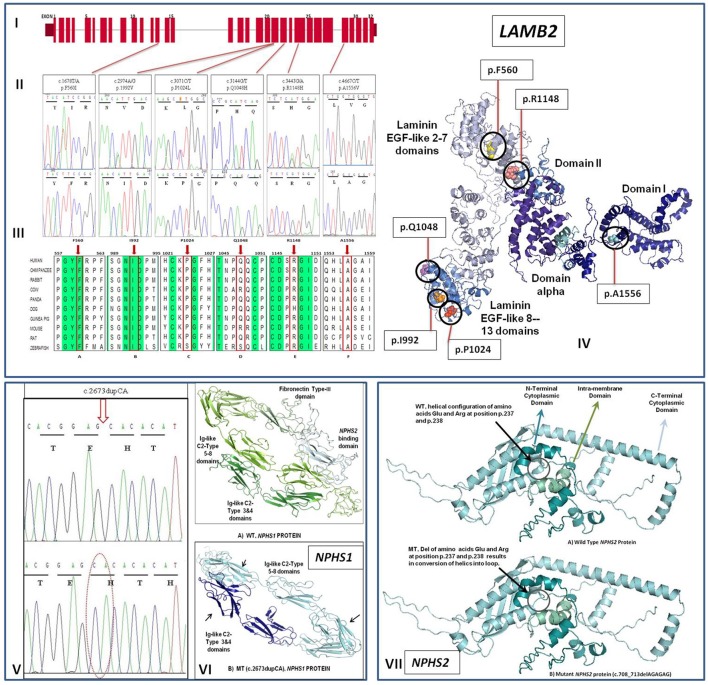
(I) Exon structure of human LAMB2 gene contains 32 exons. (II) Sequence electropherogram showing mutated (upper panel) and normal (lower panel) sequences. (III) Phylogenetic tree and MSA for LAMB2 gene showing sequence alignment of particular amino acid and its conservation in other orthologs. Conserved sequences are highlighted. (a) and (b) shows the highly conserved amino acids indicated by red frame and arrow at position 560 and 992, respectively while (c–f) shows that amino acids at position 1,024, 1,048, 1,148, and 1,556 are mostly conserved in other species. (IV) An illustration of Molecular distribution of LAMB2 missense mutations in relation to the functional domains of the protein. (V) Representative electropherogram (lower panel) of mutation (c.2673dupCA) in the NPHS1 gene compared with wild type sequence (upper panel). (VI) Conformational changes in the overall configuration of the mutant nephrin protein marked with arrows. (VII) Conformational changes in the overall configration of the mutant podocin protein (mutant positions are encircled). WT wild type, MT mutant protein.